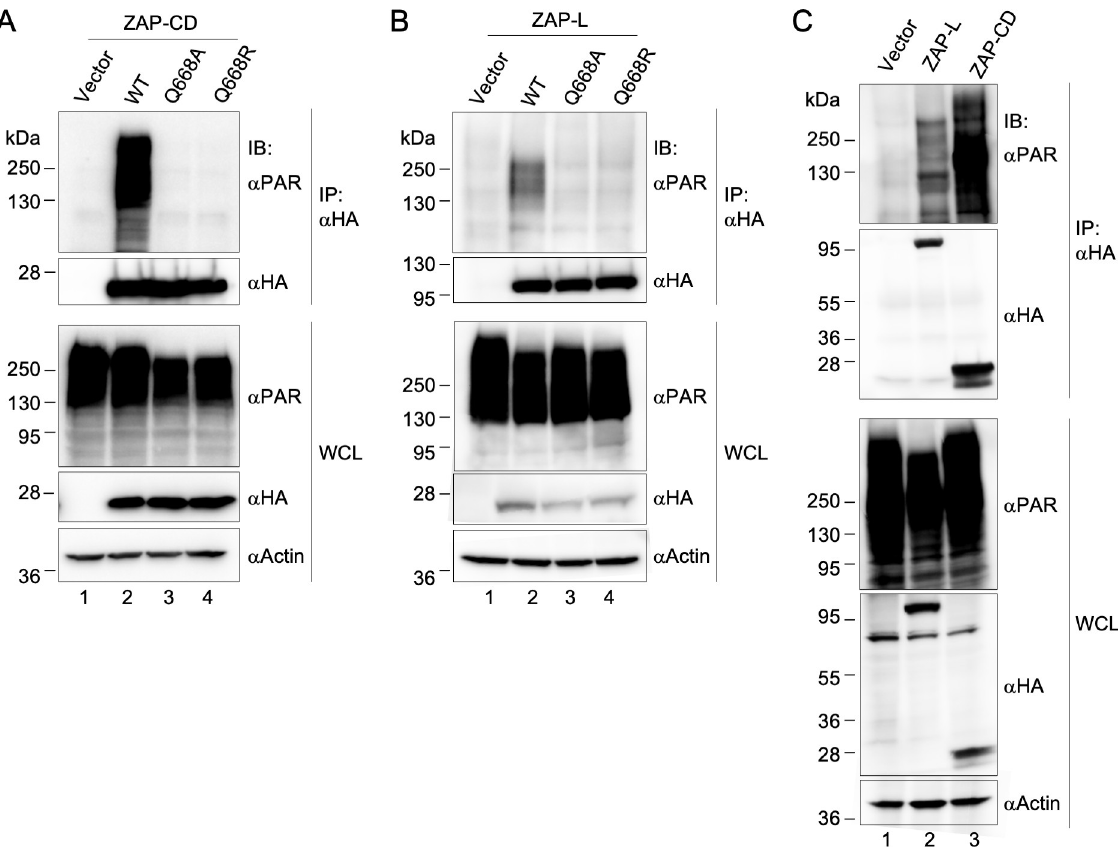
Fig 6. PAR co-immunoprecipitates with ZAP. (A-B) HEK 293T cells were transfected with empty vector or the indicated HA-tagged ZAP-CD constructs (A) or ZAP-L constructs (B). Forty-eight hours later, whole cell lysates (WCL) were subjected to pull-down with anti-HA antibody followed by immunoblotting with the indicated antibodies. Actin was used as loading control. Results are representative of three (ZAP-CD) or two (ZAP-L) independent experiments. (C) Comparison of ZAP-CD and ZAP-L.